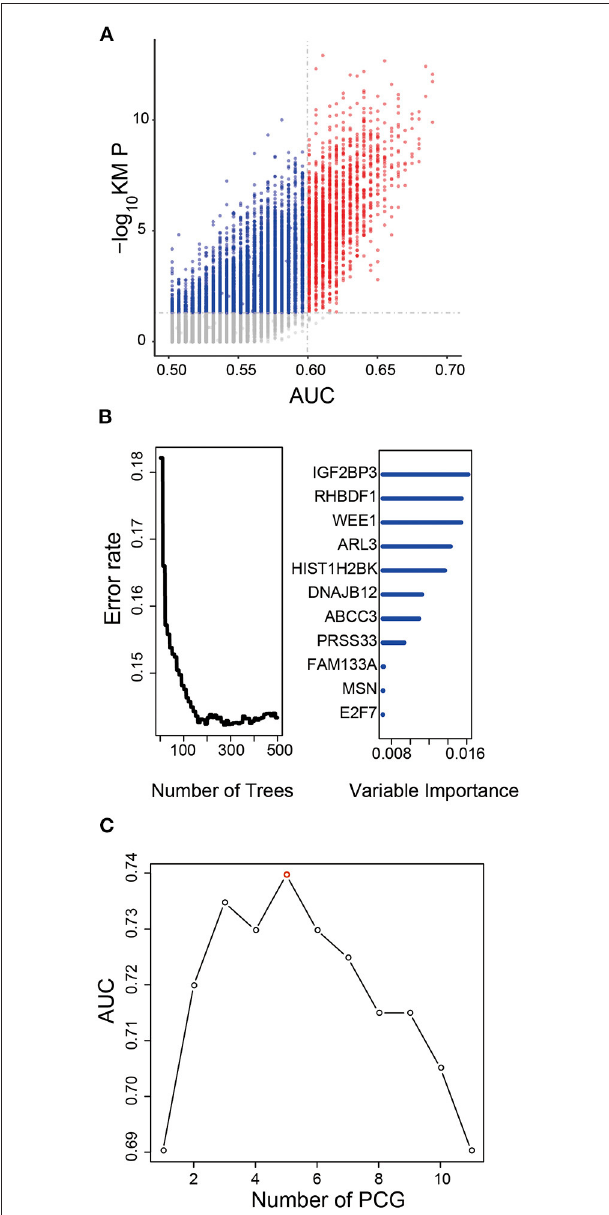
FIGURE 1 | Development of the prognostic signature in the training dataset. (A) The survival-associated PCGs in Kaplan–Meier analysis were displayed as red dots in the scatter diagram. (B) Random forest supervised classification algorithm reduced the prognosis-associated PCGs to 11 PCGs. (C) The prognostic five-PCG signature was selected because its AUC was the largest (AUC = 0.739) among the 2 11 − 1 = 2,047 signatures.